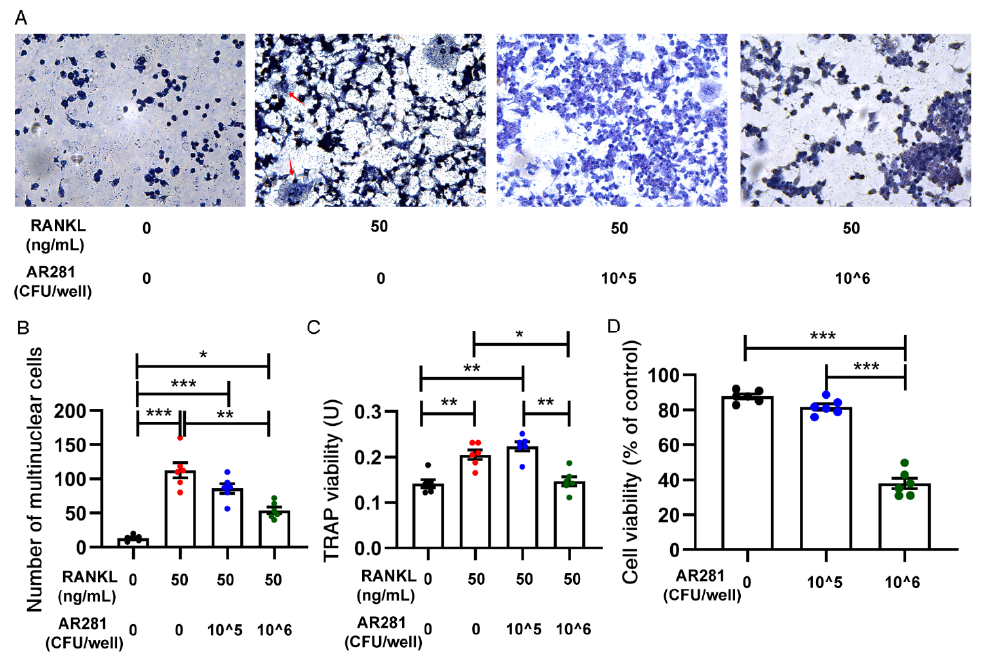
Figure 6. The effect of L. brevis AR281 on osteoclast differentiation from RAW264.7 cells: ( A , B ) the number of multinucleated cells under a light microscope (original magnification ×200); ( C ) the tartrate-resistant acid phosphatase (TRAP) activity; ( D ) the viability of RAW264.7 cells when they were co-cultured with different concentrations of AR281. Data are shown as mean ± SEM ( n = 6) and are normally distributed. * p < 0.05, ** p < 0.01, and *** p < 0.001.